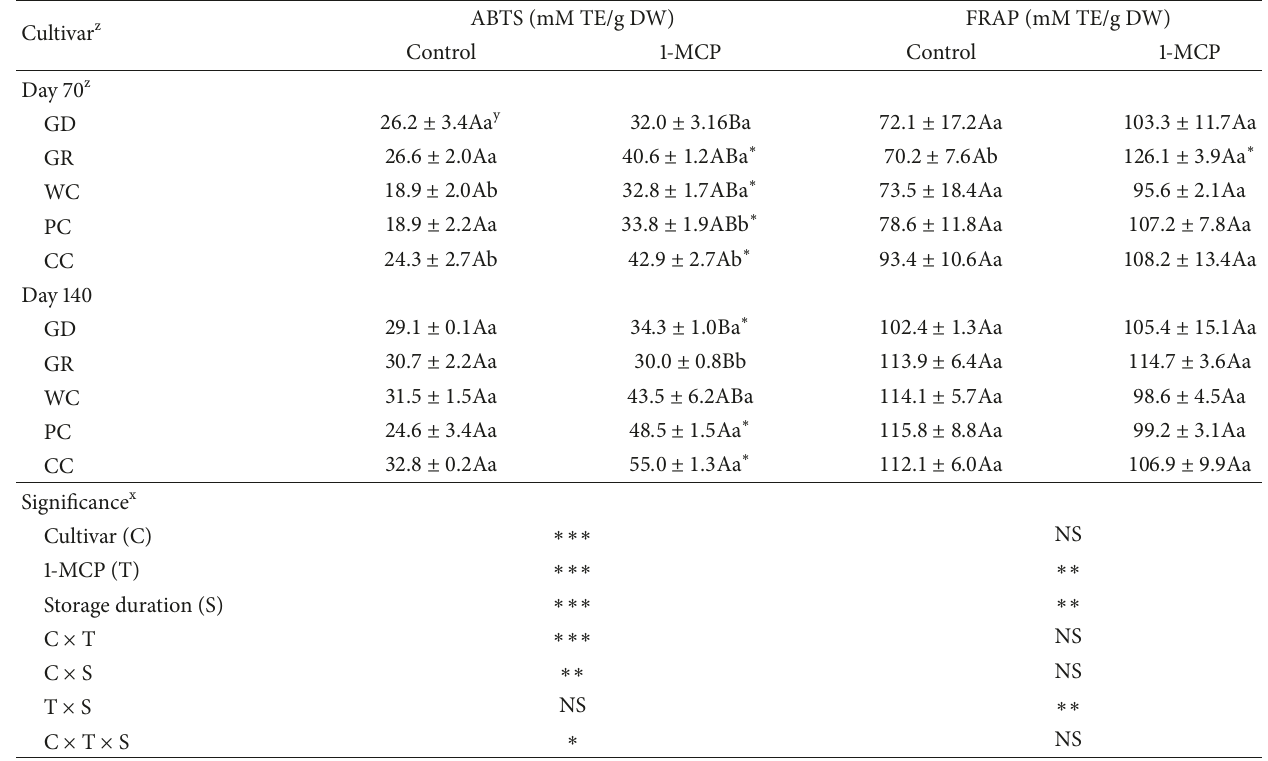
Table 3: Antioxidant capacity of apple fruit at 70 or 140 days of storage at 0 ∘ C followed by 7 days at 20 ∘ C. Cultivar